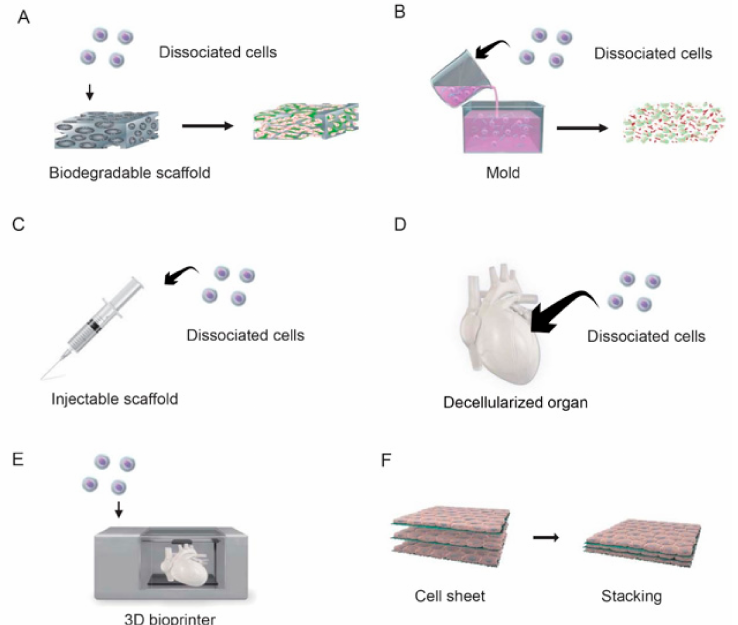
Figure 1. Approaches to myocardial tissue engineering. ( A ) Dissociated cells are poured into a pre-made, highly porous scaffold. The scaffold undergoes biodegradation, and extracellular matrix (ECM) fills the intercellular space to create a 3D tissue. ( B ) A mixture of dissociated cells and biodegradable polymers is poured into a mold, and the molecules are polymerized. Since the gel is poured into a mold, tissue of any shape can be constructed. ( C ) Cells suspended in a polymer solution are injected directly into injured/defective tissue using a syringe. This approach is similar to that used for cell infusion therapy. ( D ) Cells are actively removed from human or xenobiotic tissues and organs to leave only the ECM component, which serves as a scaffold for the seeding of dissociated cells. Since the 3D structure of the original tissue is preserved, the entire organ can be reconstructed. ( E ) A 3D printer uses a mixture of cells and polymer gel as bio-ink to assemble 3D tissues in a bottom-up fashion. ( F ) Cell sheets harvested from temperature-responsive culture surfaces are layered. The cell sheets adhere to each other via the ECM that they produce, yielding a 3D tissue that does not contain a biodegradable scaffold. The schematic diagram was drawn with the graphic design software, Adobe